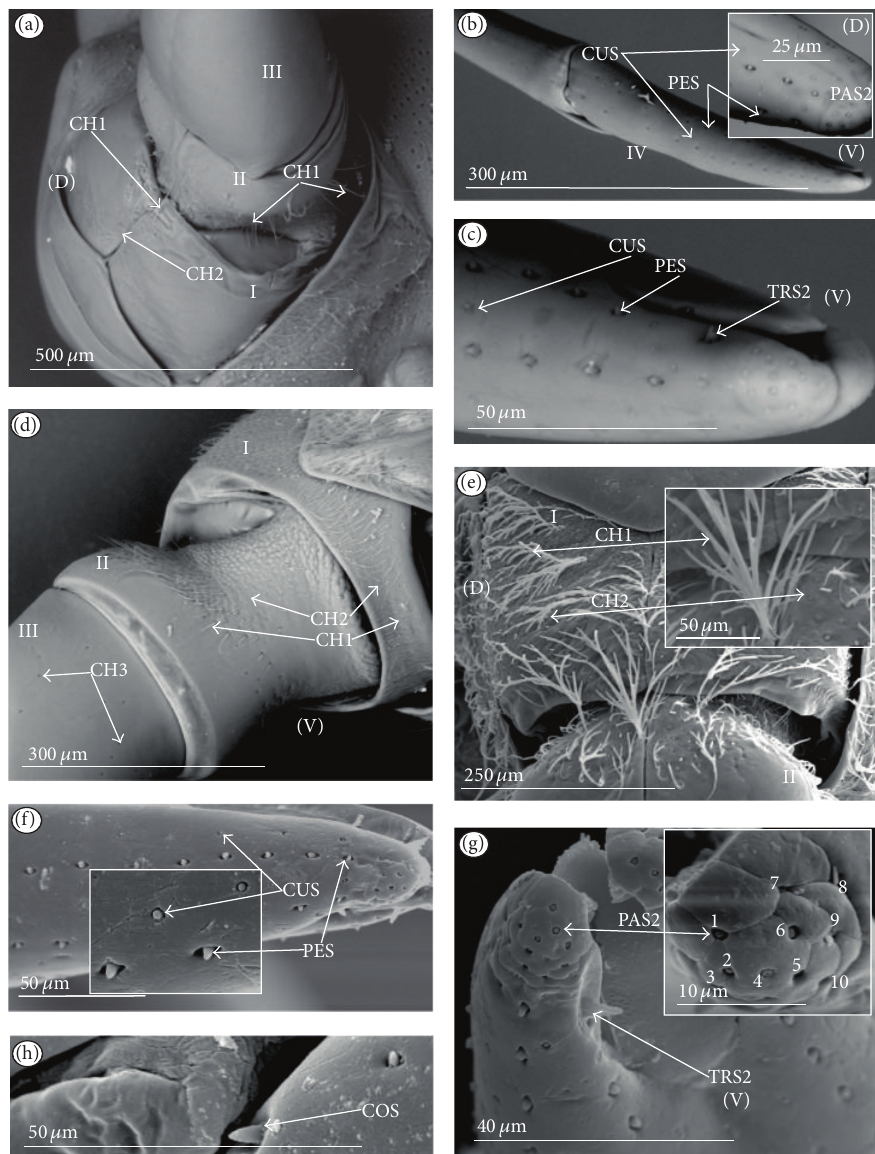
Figure 15: Types and sizes of the sensilla of the Ochteridae ((a)–(d) Ochterus piliferus , (e)–(g) O. marginatus ). ((a) and (d)) CH1, CH2 are numerous and distributed dorsally (D) and ventrally (V) on the I and II segments of the labium. ((b) and (c)) PES are numerous and cover the III and IV segments of the labium in even rows, and between two rows of pegs there is a row of CUS. PAS2 are distributed on the labial tip. One pair of TRS2 is situated near the tip of the labium. (e) CH1, CH2 are densely distributed dorsally (D) on I and II segments of the labium. (f) PES are numerous and cover the III and IV segment of the labium in even rows, and between two rows of pegs there is a row of CUS. (g) PAS2 (no. 1–10) are on the labial tip; PIP is not visible. (h) COS (prioprereceptive sensilla) are situated on segment IV, dorsally, near the base of segment